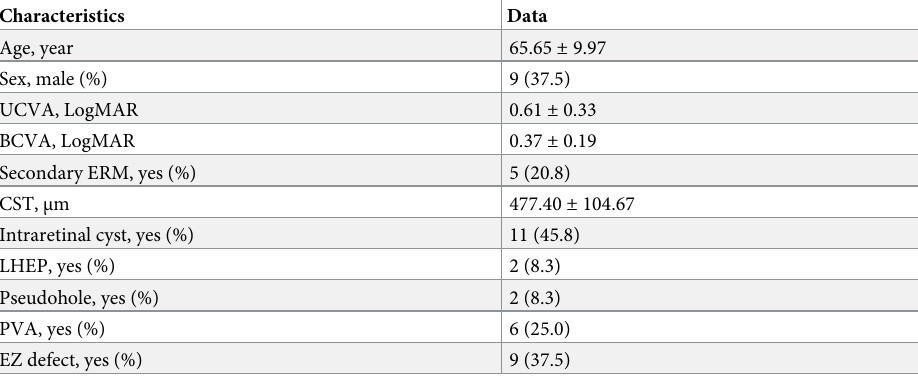
Table 1. Clinical characteristics of enrolled patients (n =